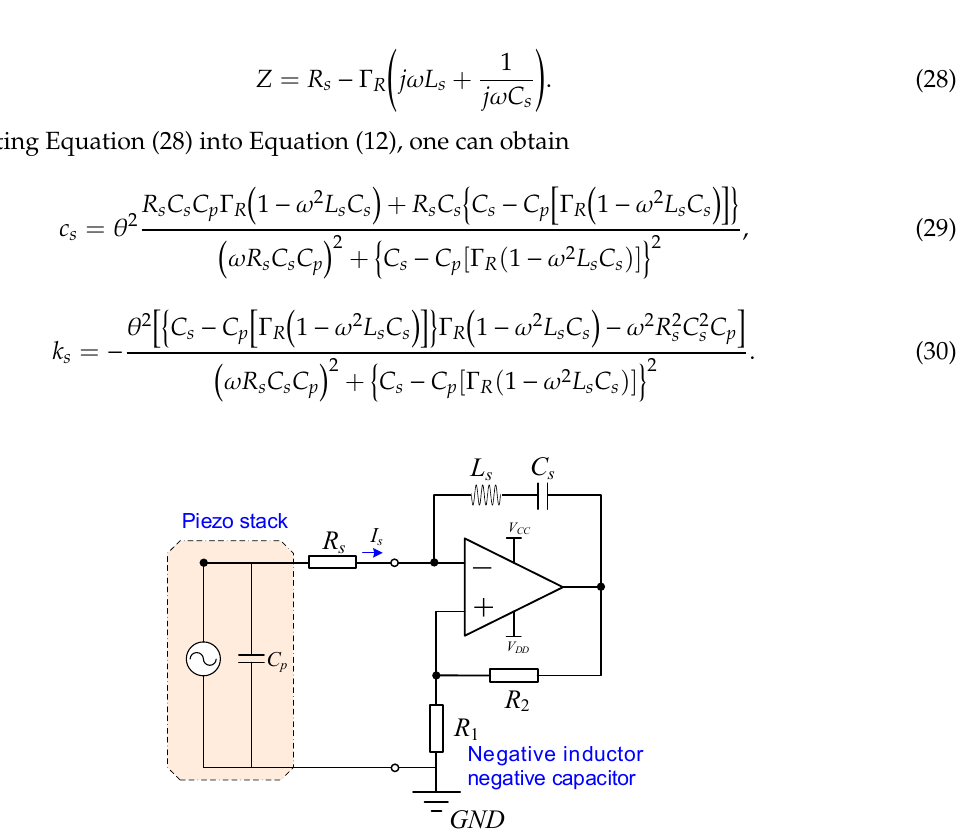
Figure 5. Schematic of the piezoelectric stack transducer with the negative inductance / negative Figure. 5 . Schematic of the piezoelectric stack transducer with the negative inductance/negative capacitance (NINC) in series with the resistance shunt capacitance (NINC) in series with the resistance shunt circuit.